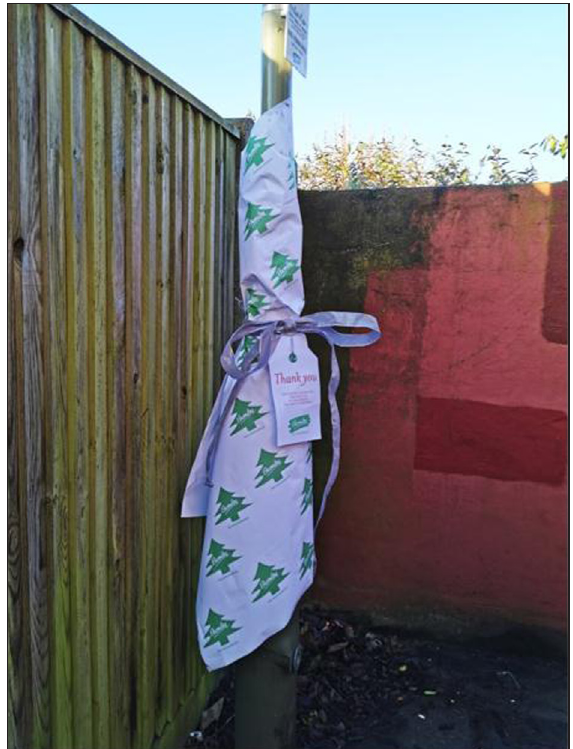
Figure 2: Experiment 4 – with branded wrapping